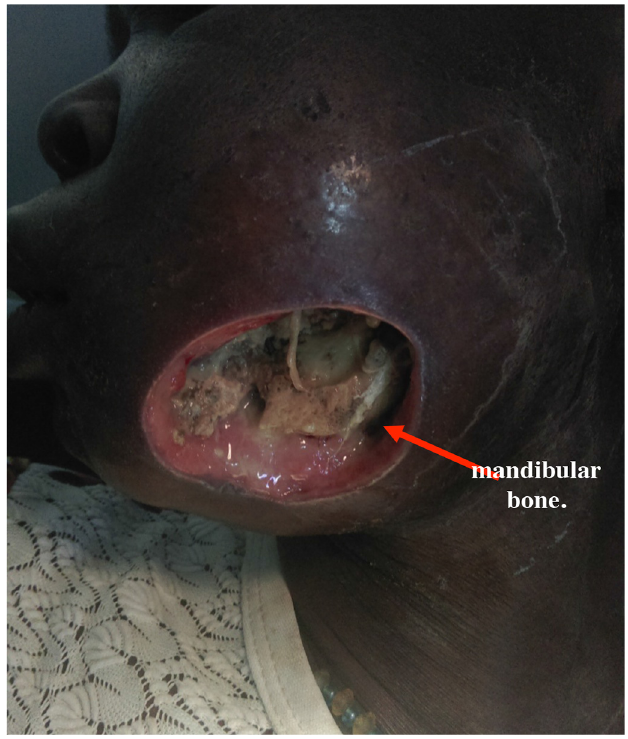
Fig. 1. Appearance of the jugulomandibular wound after cleansing, demonstrating cutaneo-oral communication and part of the necrotic mandibular